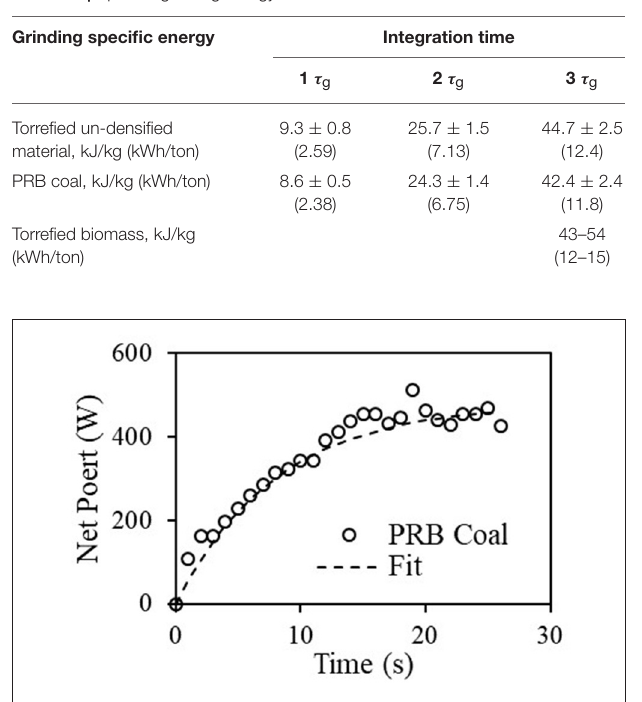
FIGURE 7 | Grinding power vs. time for PRB coal with τ g = 9.1 (s).